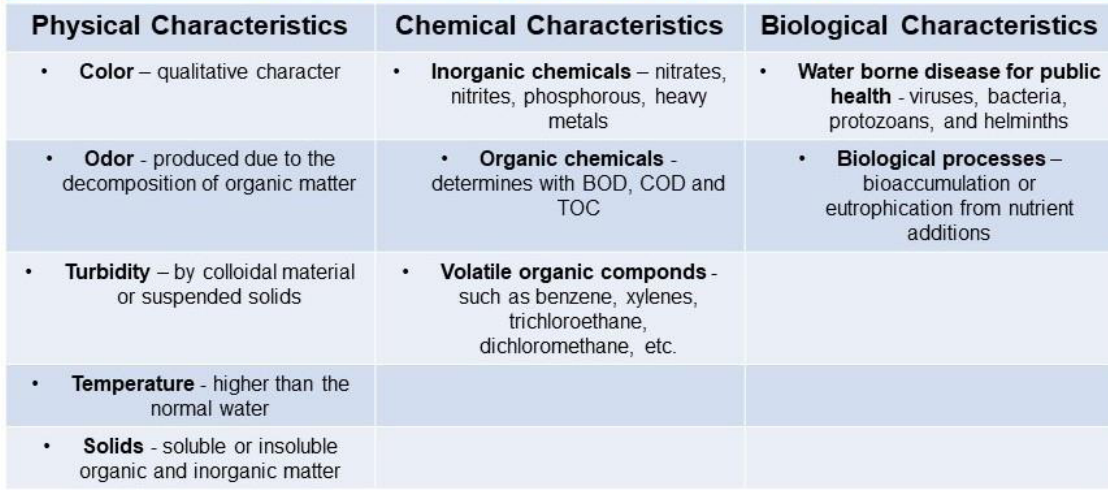
Figure 1. The characteristics of industrial wastewater.